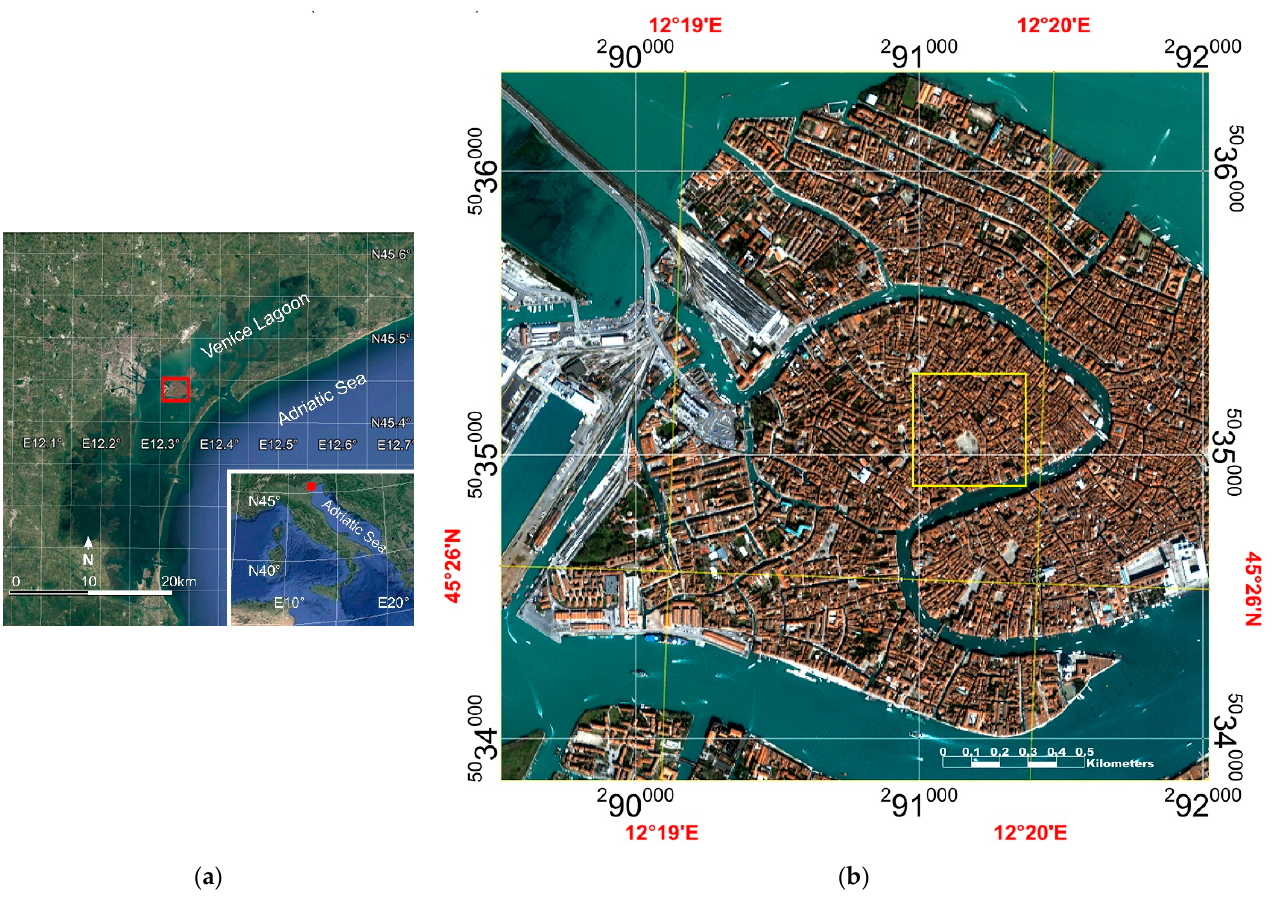
Figure 3. Study area: ( a ) study area location (red square); ( b ) IKONOS image of study